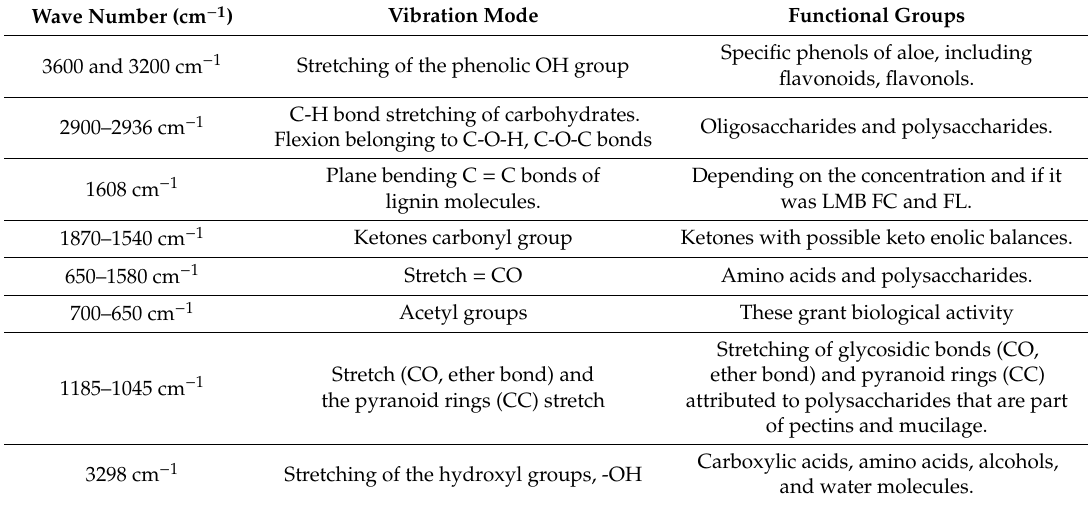
Table 5. Infrared absorption bands for the different LBMs.